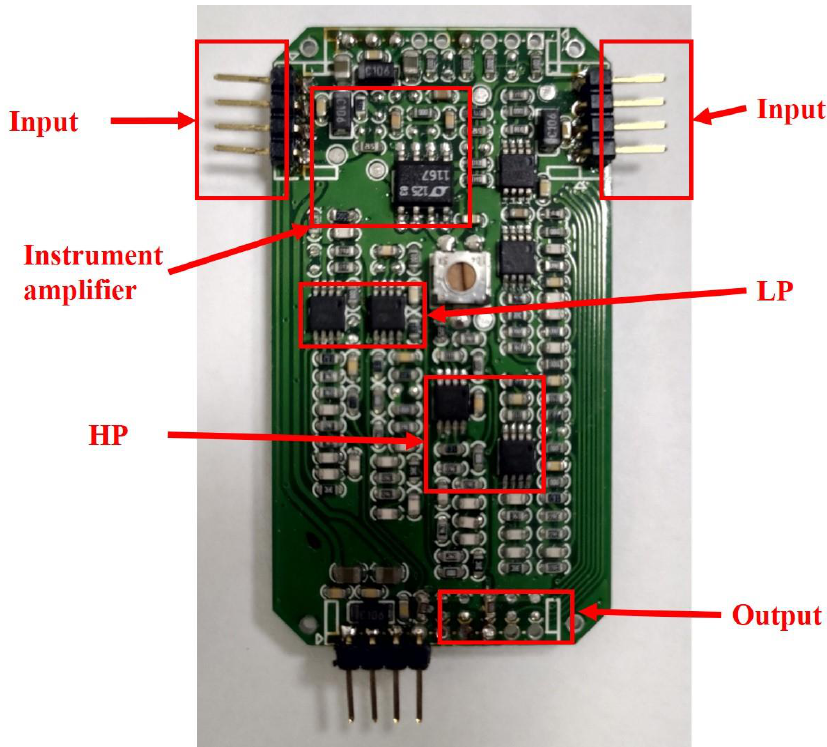
Figure 8. Block configuration and I/O terminals.